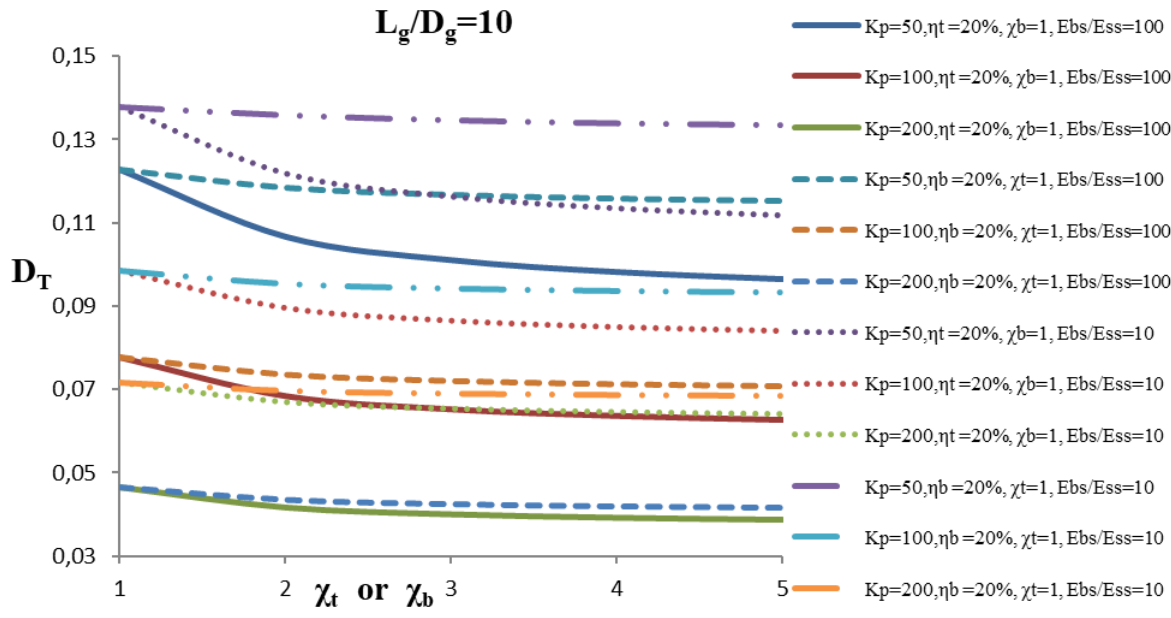
, with strengthening factor for the top, χ T ; PLST of GP, η ; PLSB of GP, η ; and relative stiffness of bearing stratum, E p t b